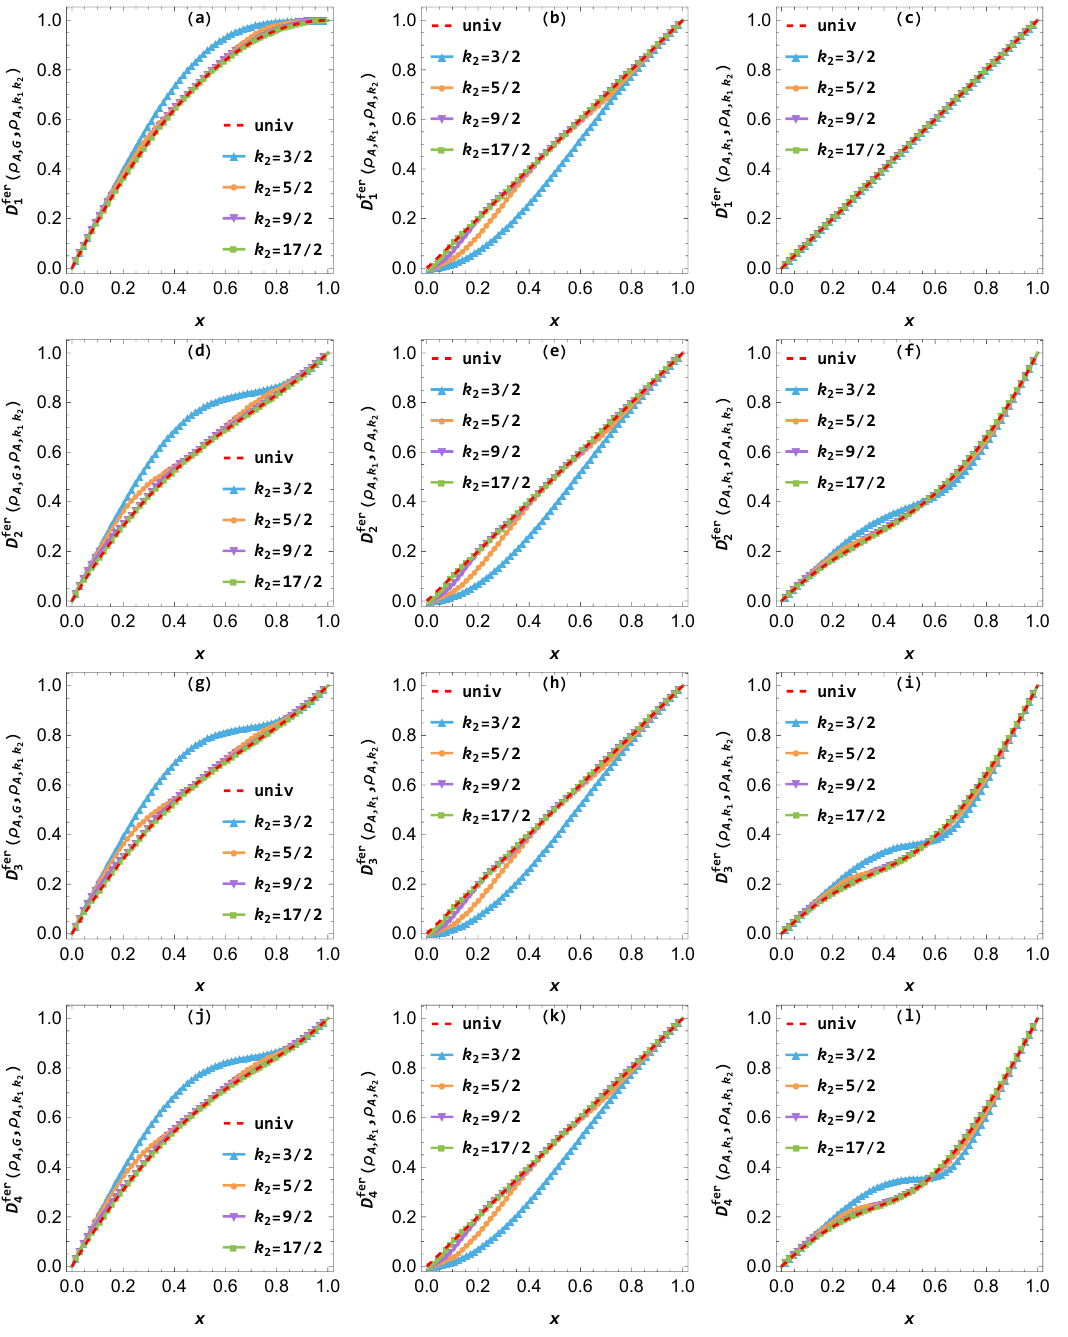
Figure 1 . The universal Schatten and trace distances from the semiclassical quasiparticle pic- ture (3.59), (3.60), (3.62), (3.65) and (3.66) (dashed red lines), the analytical Schatten and trace distances from the subsystem mode method (3.56), (3.57), (3.61), (3.63) and (3.64) (solid lines), and the numerical results from the diagonalized truncated correlation matrix method (symbols) in the free fermionic chain. We have fixed L = 64 , k = 1 / 2 . We use different colors for different values of 1 the momenta k 2